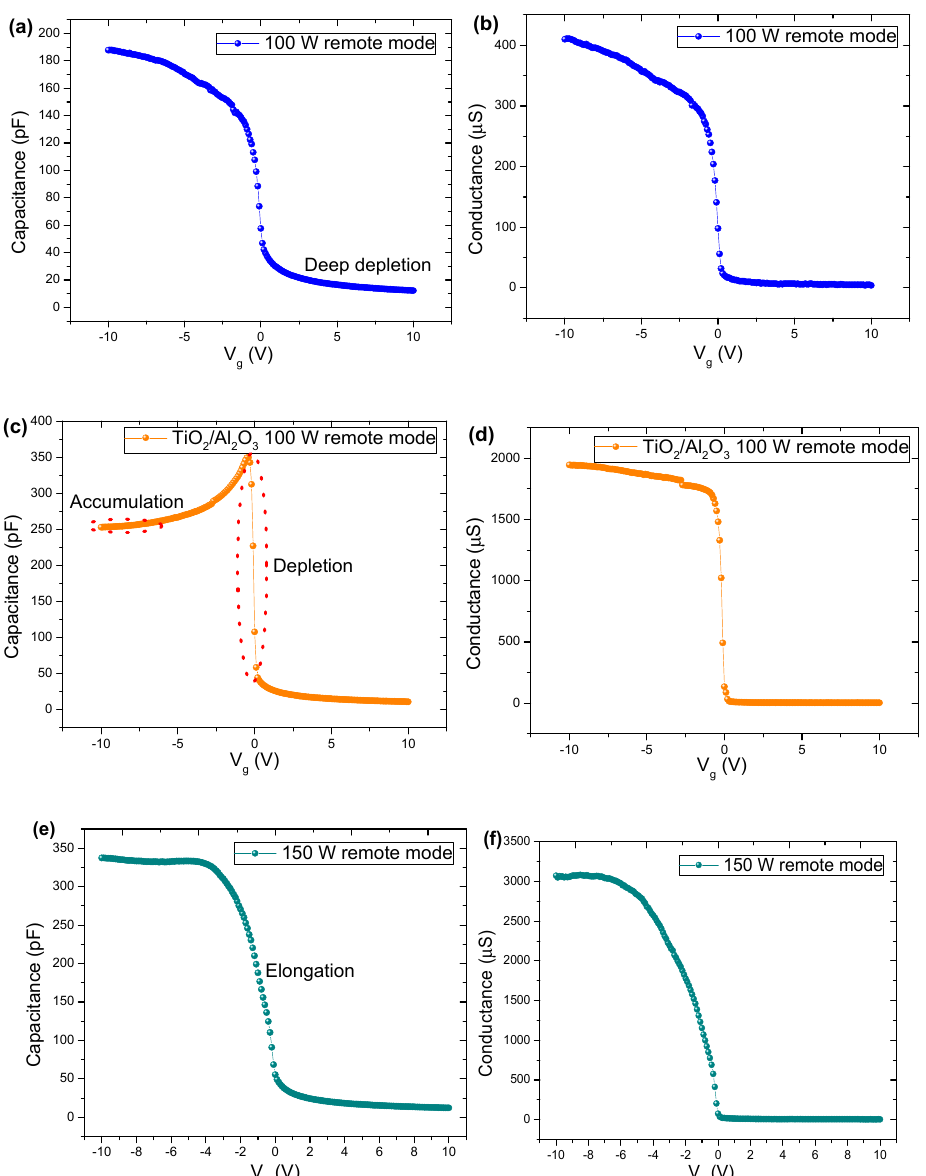
Figure 8. C-V and G-V curves for the fabricated MOS capacitors: ( a ) C-V curve for TiO 2 film grown in remote mode at 100 W, ( b ) G-V curve for TiO 2 film grown in remote mode at 100 W, ( c ) C-V curve for TiO 2 film grown in remote mode at 100 W, ( d ) G-V curve for TiO 2 /Al 2 O 3 film grown in remote mode at 100 W, ( e ) C-V curve for TiO 2 film grown in remote mode at 150 W and ( f ) G-V curve for TiO 2 film grown in remote mode at 150 W.